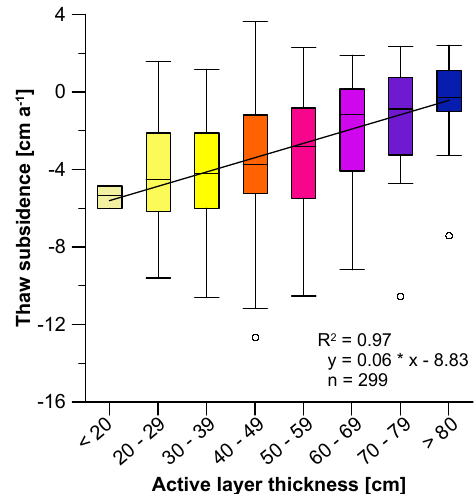
Figure 10. Classified observations of active layer thickness (ALT) in August 2012 in relation to mean annual permafrost thaw subsi- dence from 1951 to 2013 show intensified subsidence in places of shallow ALT. The outliers are indicated by open circles. The colour code is adjusted to ALT classification in Fig. 4. Inverse relation of ALT and subsidence indicates water drainage on the permafrost– active layer interface and consequently irreversible ground ice